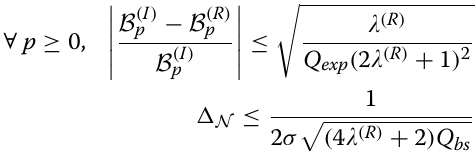
Algorithm 8. The error of Algorithm 8 stems from the N ( R ) ( 0, 1 ) approximate distribution and the approximate B ( R ) B ( R ) Bernoulli variables p rej . The proof of Theorem 11 is p 0 , similar to that of Theorem 7, except estimating the influ- N ( 0, 1 ) ence of the continuous distribution . We provide the detailed proofs of Theorems 10 and 11 in